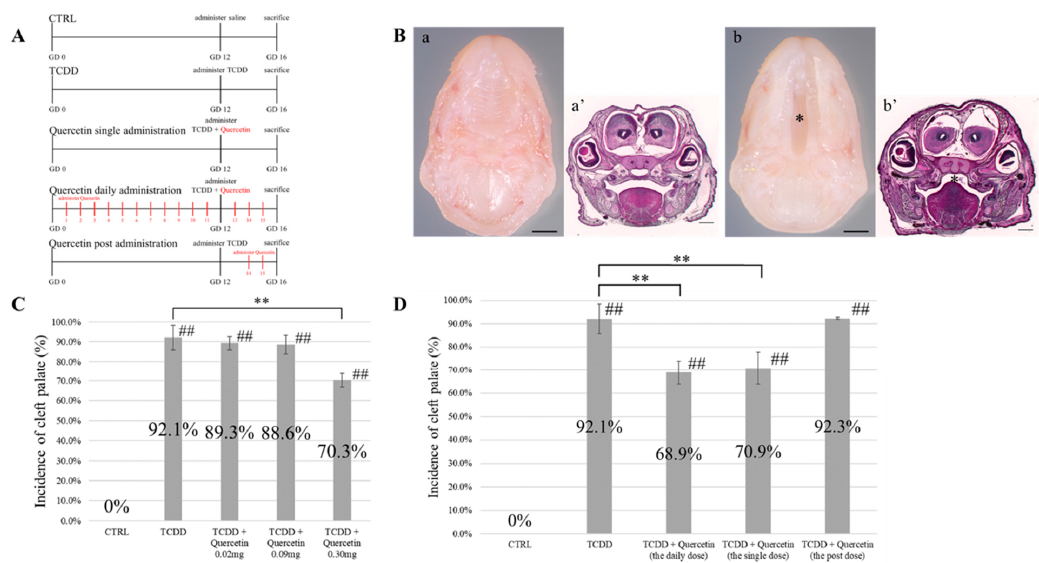
Figure 1. ( A ) Schematic diagram of TCDD and quercetin dosing schedule for control (CTRL) group, 2,3,7,8-tetrachlorodibenzo-p-dioxin (TCDD) group, Quercetin (daily administration) + TCDD group, Quercetin (single administration) + TCDD group, and Quercetin (post-administration) + TCDD group. Mice were euthanized on gestational day 16 (GD16). ( B ) Gross findings (a) and histo- logical sections (a’) of a normal palate. Gross findings (b) and histological sections (b’) of a cleft palate. Scale bars = 500 μ m. *: cleft palate area. ( C ) Incidence of cleft palate in the CTRL group, TCDD group, TCDD + Quercetin 0.02 mg group, TCDD + Quercetin 0.09 mg group, and TCDD + Quercetin 0.30 mg group. * p < 0.05; ** p < 0.01 vs. TCDD. ## p < 0.01 vs. CTRL. ( D ) Incidence of cleft palate in the CTRL group, TCDD group, TCDD + Quercetin (daily administration) group, TCDD + Quercetin (single administration) group, and TCDD + Quercetin (post-administration) group. * p < 0.05; ** p < 0.01 vs. TCDD. ## p < 0.01 vs. CTRL. 2.4. Cell Culture Pregnant mice were euthanized at the GD12 stage, and the fetuses were collected. Only the palate mucosa of the fetal mice was selectively isolated under a microscope and digested with dispase II (Godo Shusei Co., Tokyo, Japan) and trypsin EDTA (Biological Industries, Beit Haemek, Israel) at 37 °C for 30 min. After centrifugation, mouse embry- onic palatal mesenchymal (MEPM) cells were isolated using a cell strainer with a pore size of 70 μ m (BD Falcon, Phoenix, AZ, USA). Cells were seeded in DMEM (DMEM, 10% FBS, 1% penicillin/streptomycin, 1% amphotericin B) and cultured for 3 days. The cells were maintained at 37 °C in an atmosphere containing 5% CO 2 . After confirming that the cul- ture was 80% confluent, the cells were divided into four groups for further experiments and passaged. The breakdown of the four groups is presented as follows: 0.1% DMSO (Group 1: CTRL), 0.1% DMSO + 10 nM TCDD (Group 2: TCDD), 0.1% DMSO + 1 μ M Quercetin (Group 3: Quercetin), and 0.1% DMSO + 10 nM TCDD + 1 μ M Quercetin (Group 4: TCDD + Quercetin). A TCDD concentration of 10 nM has been established in previous studies as an effective concentration for AhR activation [15].